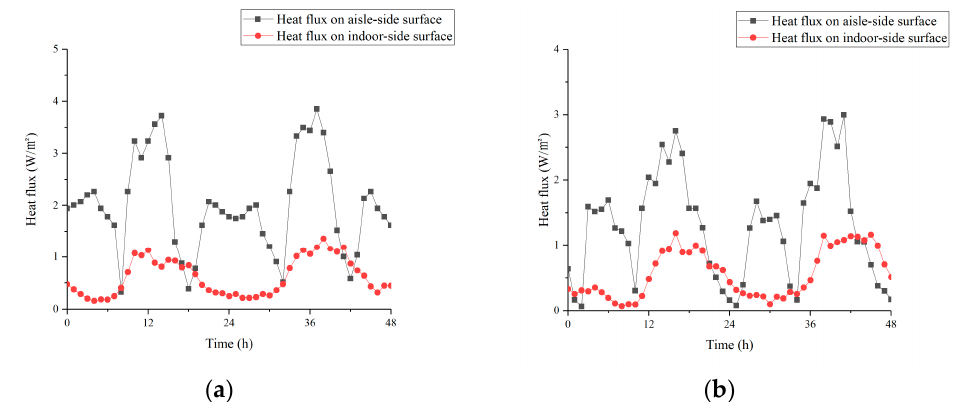
Figure 14. Heat flux of different ceiling surfaces under two strategies ( a ) 12 h; ( b ) 8 h.